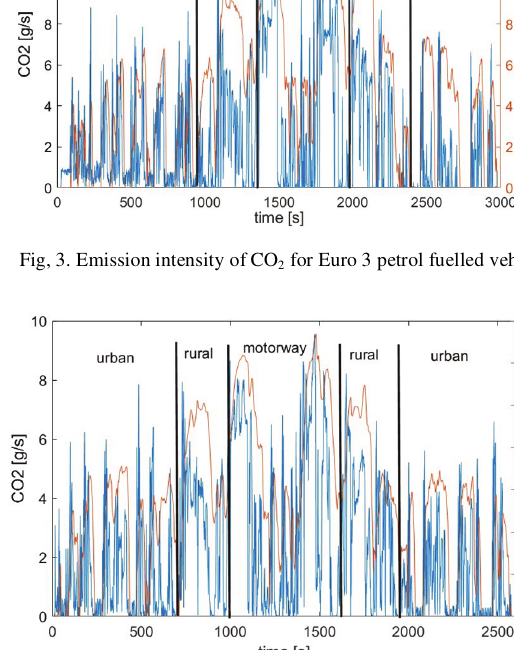
Table. 1. Selected technical parameters of the PEMS Horiba OBS-2200 system Parameter